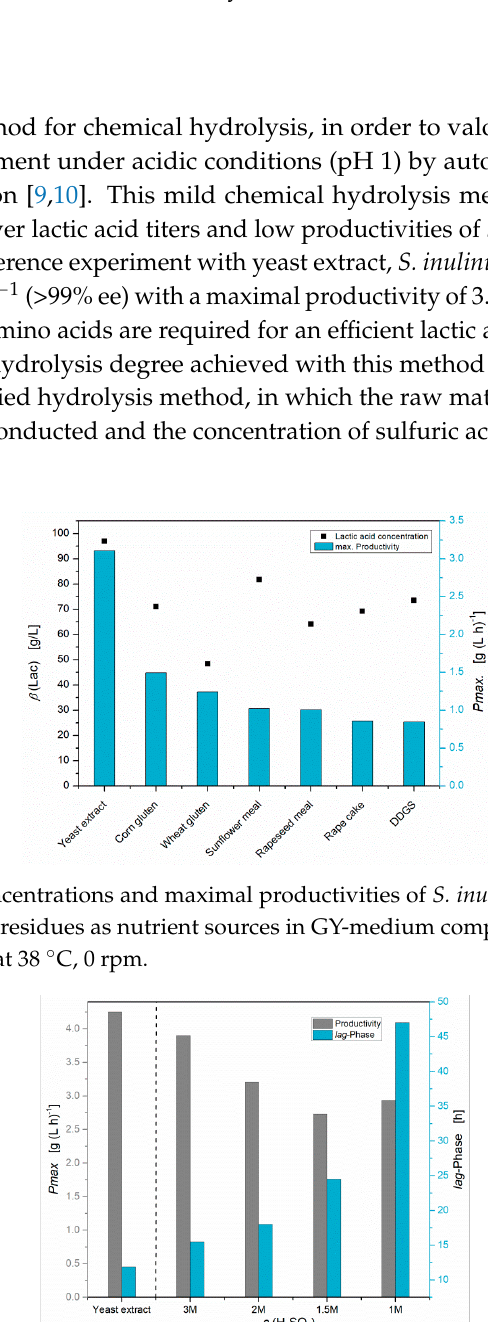
Figure 2. Influence of sulfuric acid concentration variation during chemical hydrolysis of DDGS on the maximal productivity and lag-phase of S. inulinus cultivation at 38 ◦ C, 0